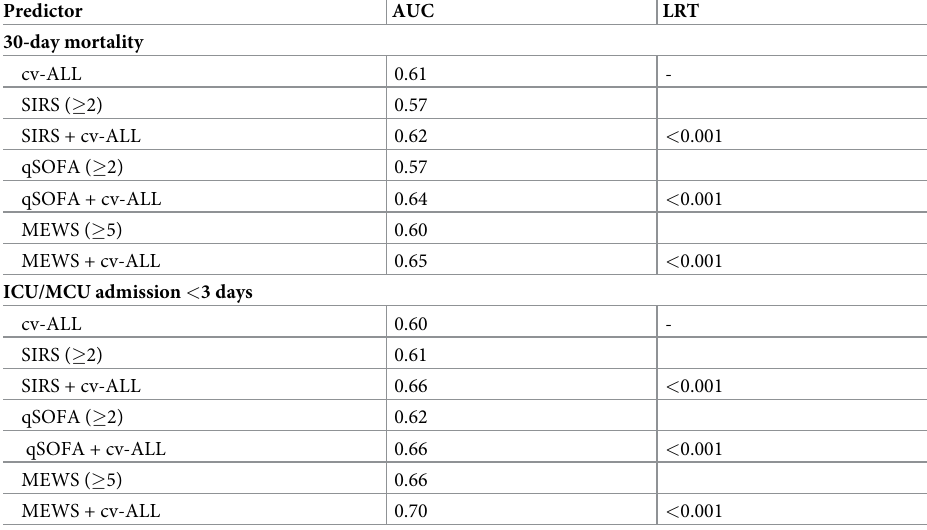
Table 3. AUC of clinical prediction scores with(out) cv-ALL of monocytes. Predictor AUC LRT 30-day mortality cv-ALL 0.61 - SIRS ( � 2) 0.57 SIRS + cv-ALL 0.62 < 0.001 qSOFA ( � 2) 0.57 qSOFA + cv-ALL 0.64 < 0.001 MEWS ( � 5) 0.60 0.65 < 0.001 ICU/MCU admission < 3 days cv-ALL 0.60 - SIRS ( � 2) 0.61 SIRS + cv-ALL 0.66 < 0.001 qSOFA ( � 2) 0.62 qSOFA + cv-ALL 0.66 < 0.001 MEWS ( � 5) 0.66 MEWS + cv-ALL 0.70 < 0.001 cv-ALL, Coefficient of Variance Axial Light Loss; LRT, Likelihood Ratio Test; qSOFA, quick Sequential Organ Failure Assessment; OR, odds ratio; CI, confidence